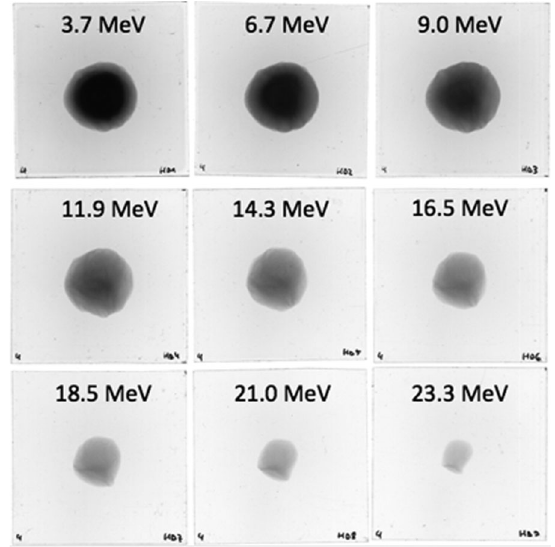
FIG. 2. Direct measurement of laser accelerated protons from a single PHELIX laser pulse. The low energy protons deposit a larger dose and have a larger beam profile than the higher energy protons.